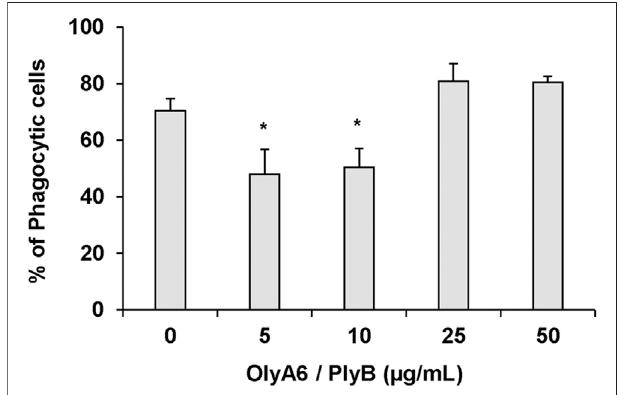
FIGURE 7 | Effects of the OlyA6/PlyB mixture on phagocytic activity of M. galloprovincialis hemocytes. Hemocytes were exposed to different concentrations of the protein mixture (5, 10, 25, 50 μ g/ml; OlyA6/PlyB molar ratio 12.5/1). Data, representing the mean ± SD of four experiments in triplicate, were analysed by the Mann Whitney U test. * p <